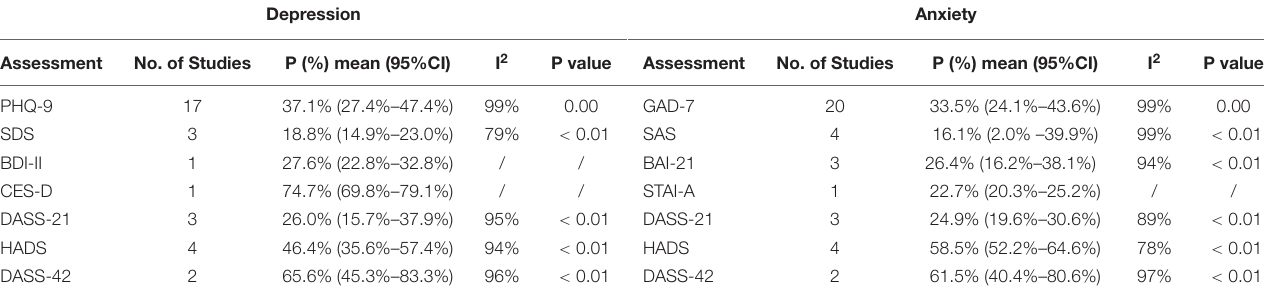
FIGURE 3 | Forest plot for anxiety. TABLE 2 | Subgroup analysis of